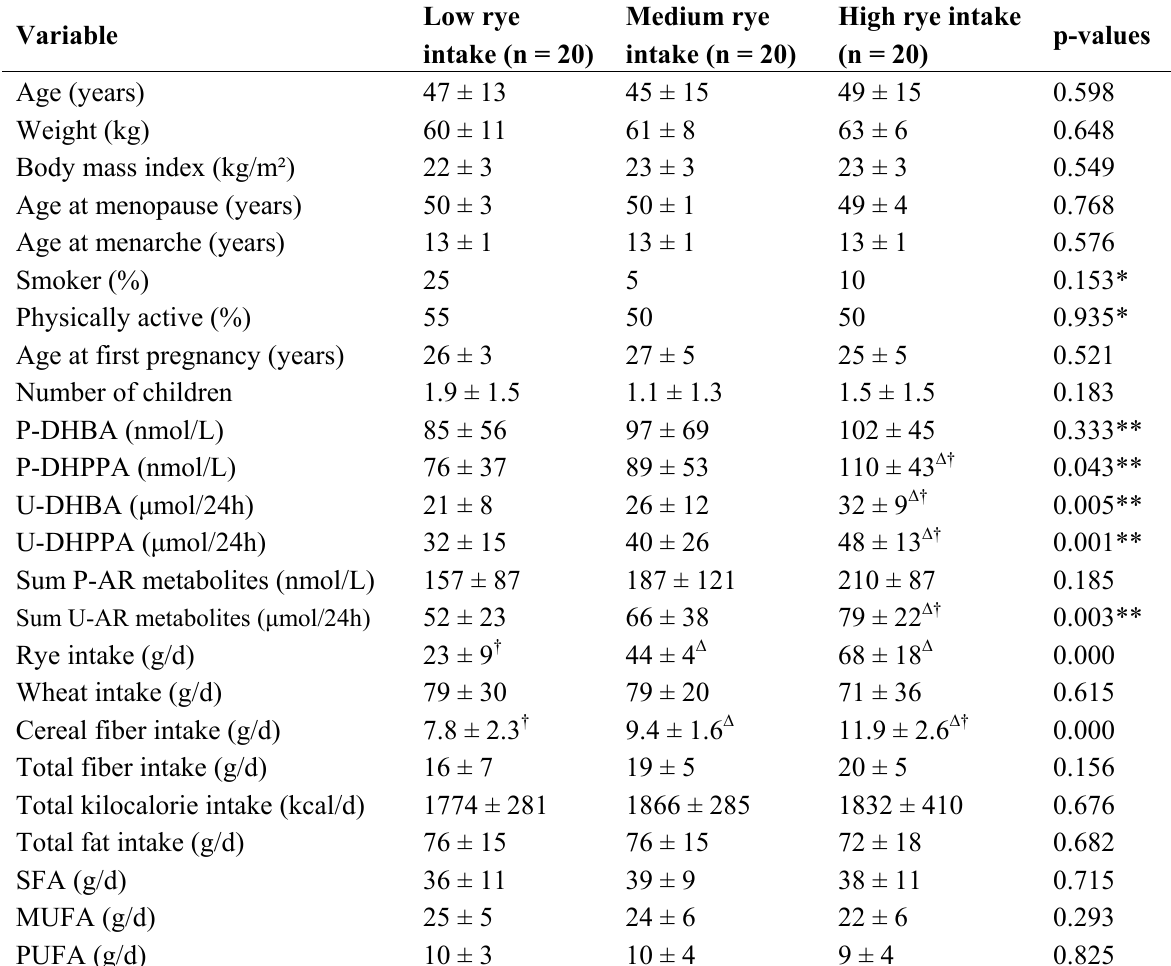
Table 1. Descriptive characteristics of the